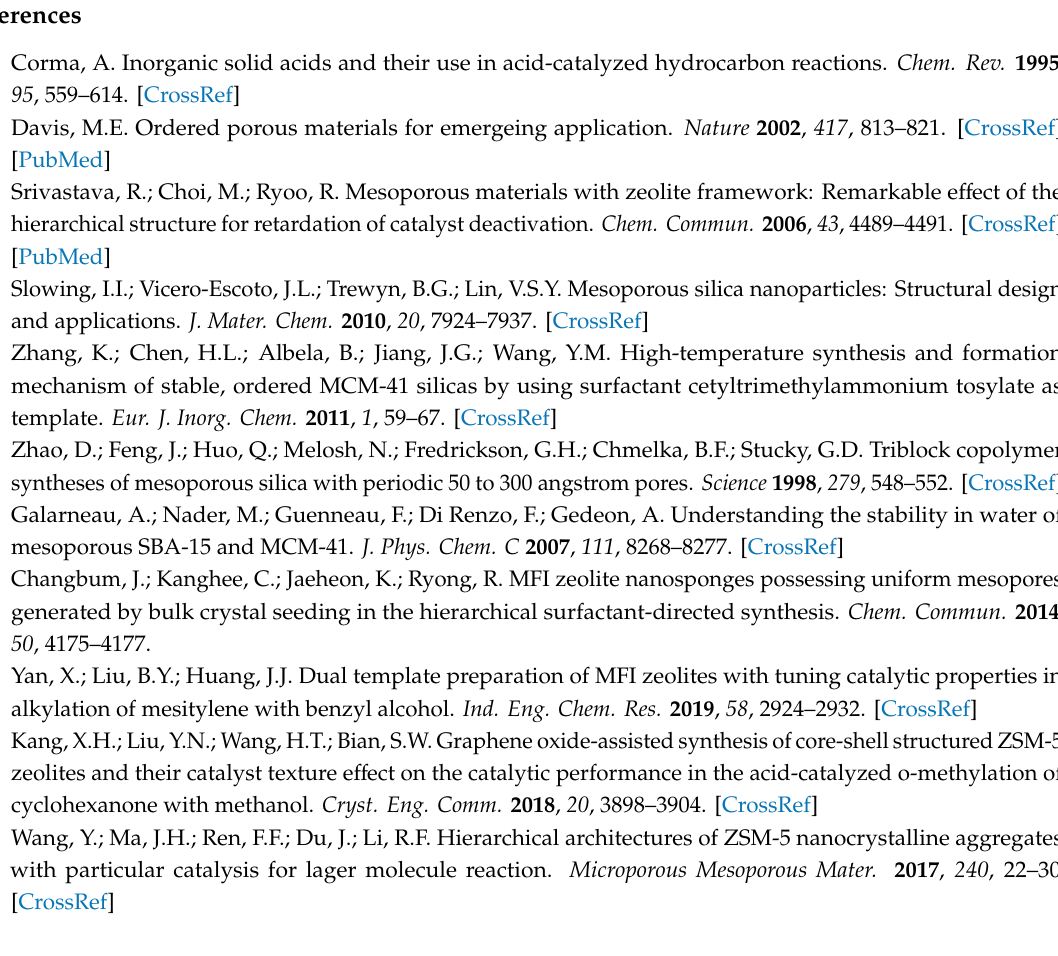
Figure S1: The schematic diagram of micro activity test unit, Figure S2: Elemental analysis with the EDS mounted on the SEM of HPZ-CSI-8h samples, Figure S3: TG / DTA curves of HPZ-CSI-8h and ZSM-5 samples, Figure S4: N 2 adsorption-desorption isotherms and pore size distribution of ZSM-5, SBA-15, MSiC-0.4 and HPZ-CSI-8h samples, Figure S5: Pyridine-adsorbed IR spectra of HPZ-CSI-8h and ZSM-5 samples. Author Contributions: R.L. conceived and designed the experiments; J.D. and Y.W. 2 performed the experiments; R.L. and J.D. analyzed the data; Y.W. 1 and J.D. wrote the paper. All authors have read and agreed to the published version of the